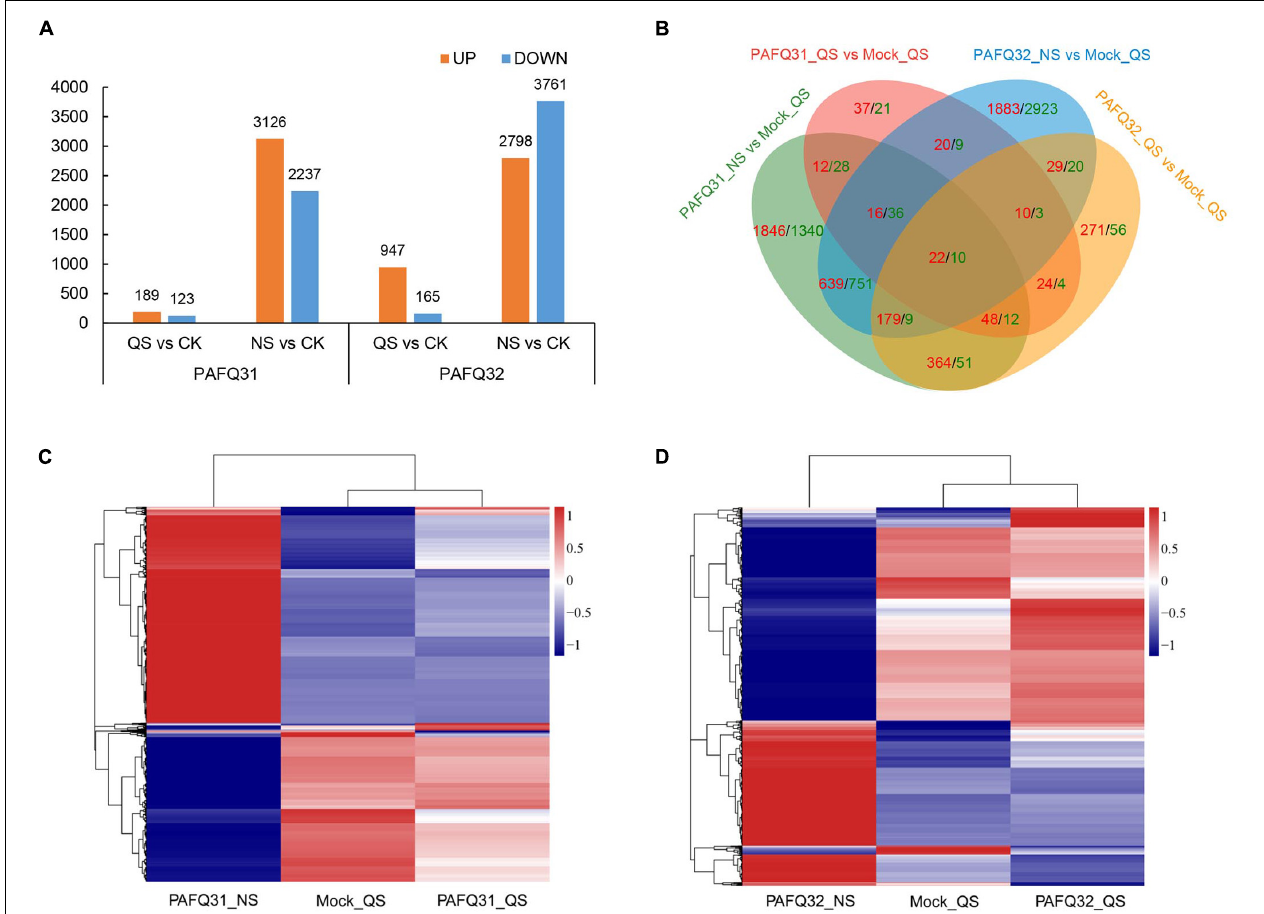
FIGURE 2 | Transcriptome analysis of pear leaves at quiescent stage (QS) and necrotrophic stage (NS) after inoculation by two C. fructicola strains. (A) Statistical analysis of upregulated and downregulated differential expression genes (DEGs) in response to the infection of both C. fructicola strains at QS and NS, respectively. (B) Venn diagrams of the upregulated and downregulated DEGs of P. pyrifolia , indicated by red and green color, respectively, as compared with controls for each strain. (C,D) Heatmap analysis for 5,485 and 7,122 DEGs with at least a twofold expression differences with a p -value < 0.05 as in response to the infection of strain PAFQ31 (C) and PAFQ32 (D) , respectively. The bars indicate the standardized log 2 (FPKM) accompanies the expression profile, ranging from navy (-1) to white (0) to firebrick3